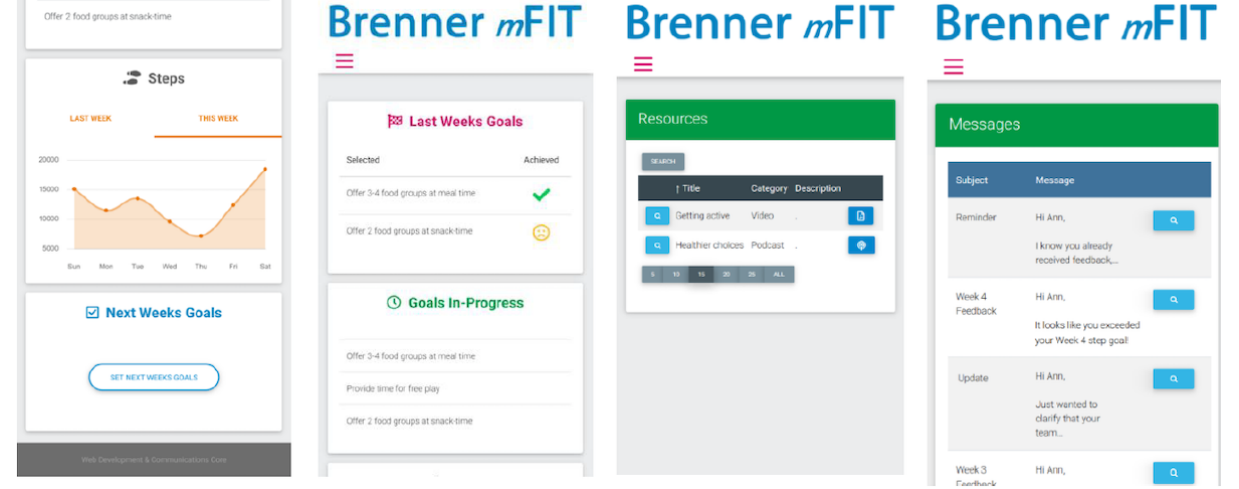
Figure 1. Screenshots showing (left to right) physical activity monitoring, goal setting, resources, and message